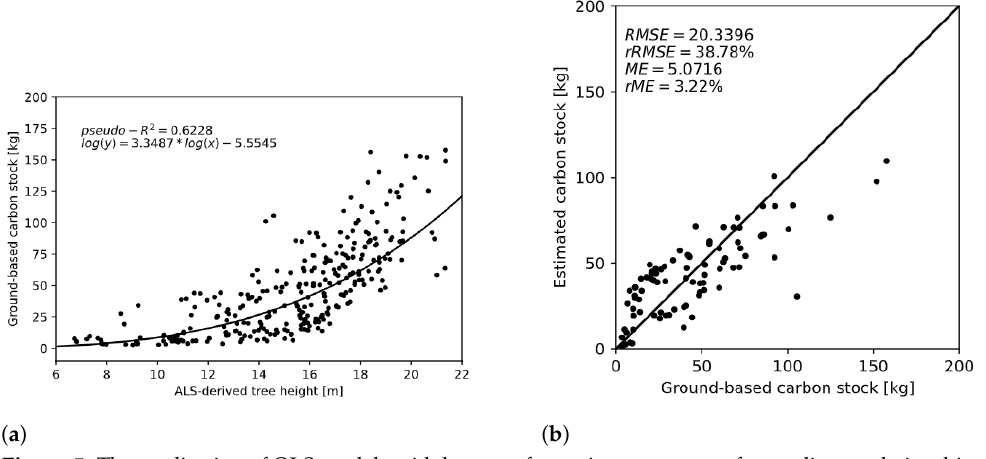
Figure 5. The application of OLS models with log transformations to account for nonlinear relationships between the ALS-derived tree height and ground-based carbon stock ( a ) and the results of the ground- based carbon stock versus estimation from ALS-derived tree height on the validation dataset ( b ).